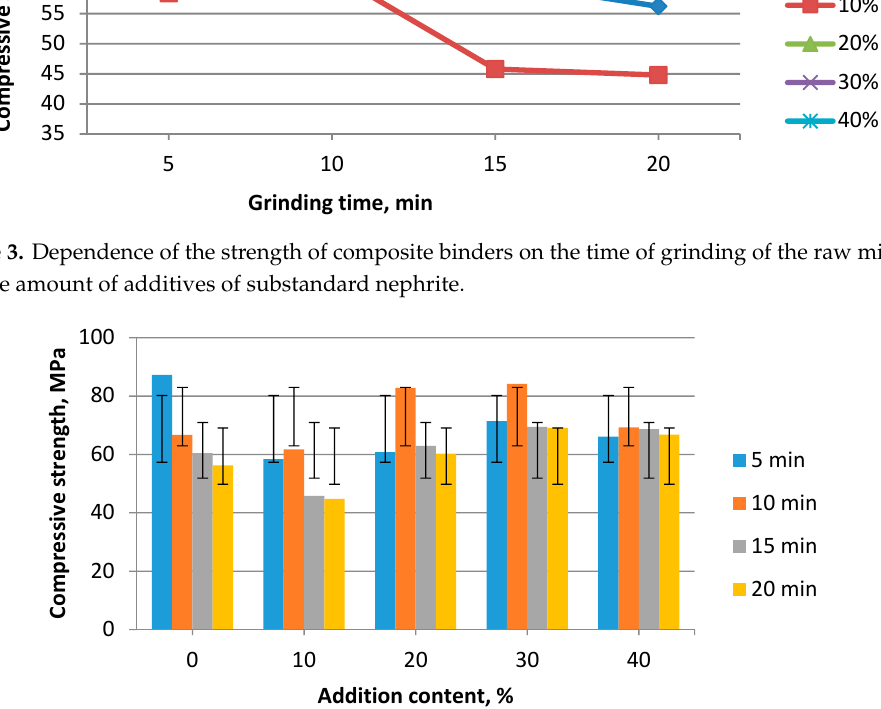
Figure 4. Dependence of the strength of composite binders on the amount of additives of the substandard nephrite.